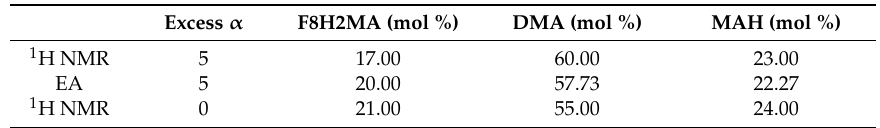
Table 9. Comparison of the copolymer C2 composition calculated from elemental analysis (EA) and 1 H-NMR data for continuous addition and low conversion ( α = 0).